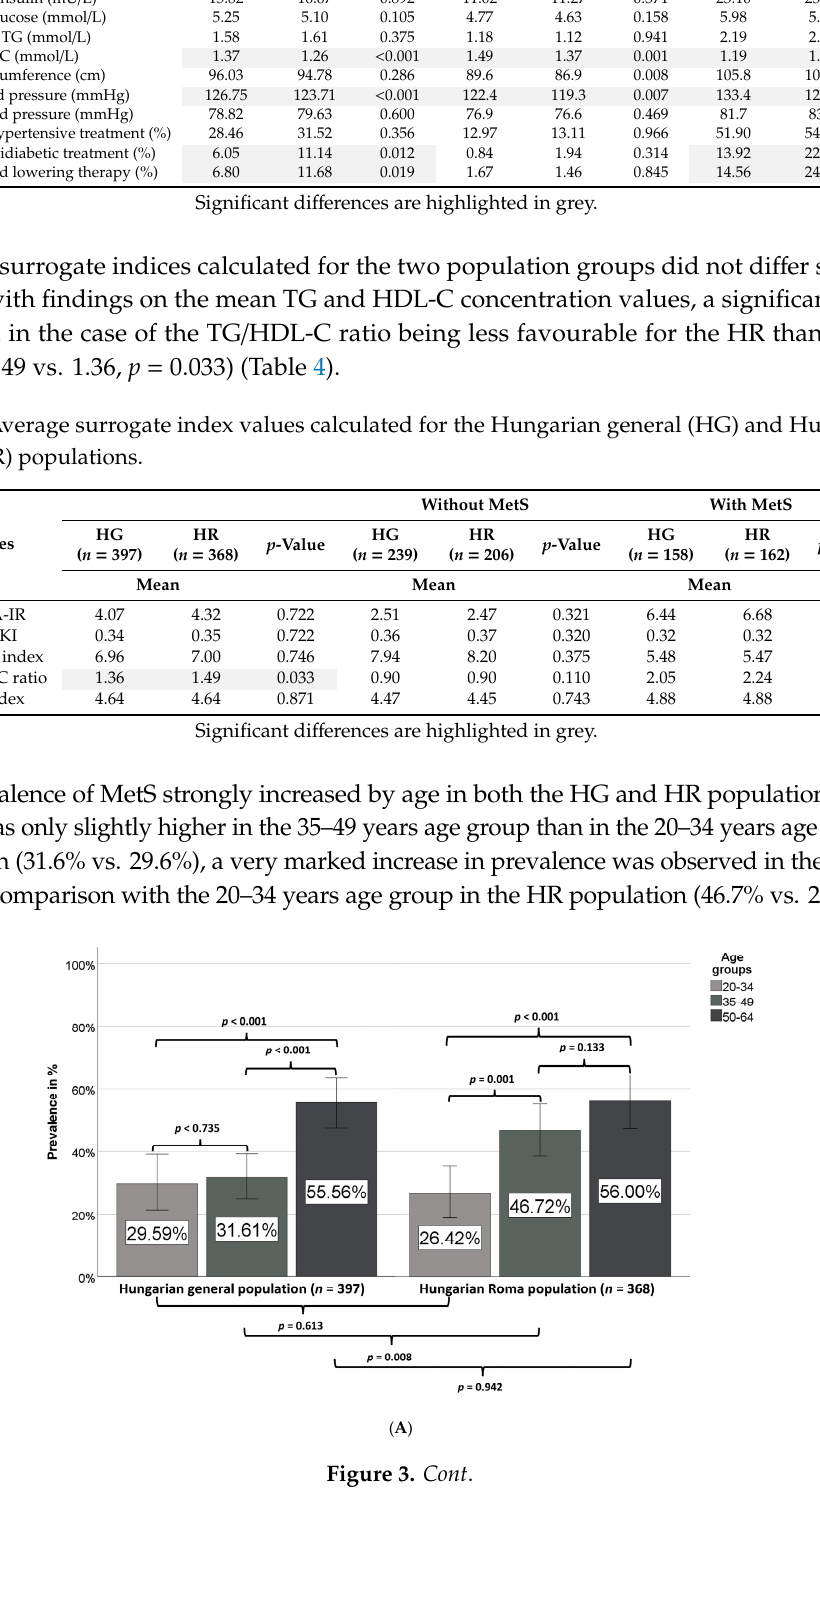
Table 3. Mean value of biochemical and physical parameters used to estimate the risk of insulin resistance and metabolic syndrome in the Hungarian general (HG) and Hungarian Roma (HR) populations furthermore obtained on samples without and with metabolic syndrome. Without Mets With Mets HG HR HG HR HG HR ( n = 239) ( n = 206) p -Value ( n = 397) ( n = 368) p -Value ( n = 158) ( n = 162) p -Value Mean Mean Mean Fasting insulin (mU / L) 15.82